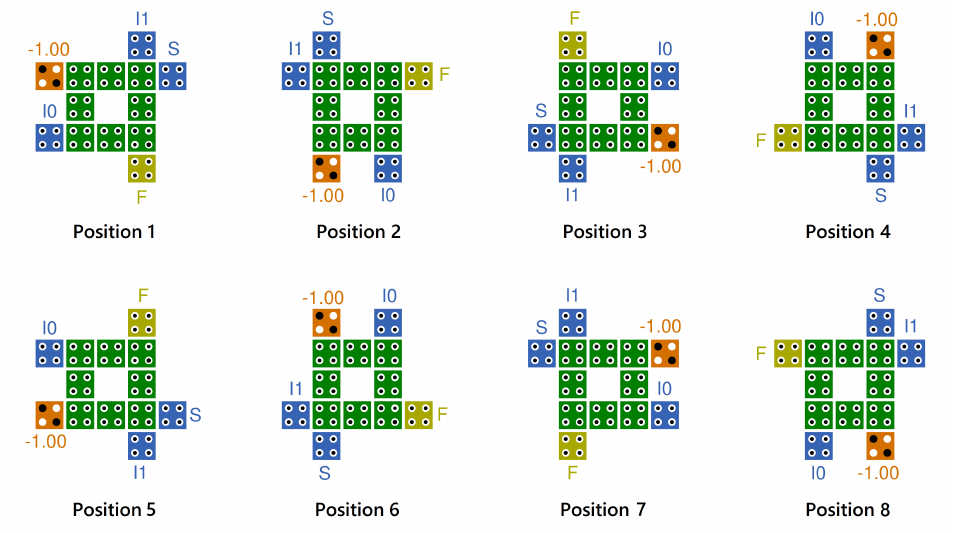
Figure 2. Different possible positions for MUX1.